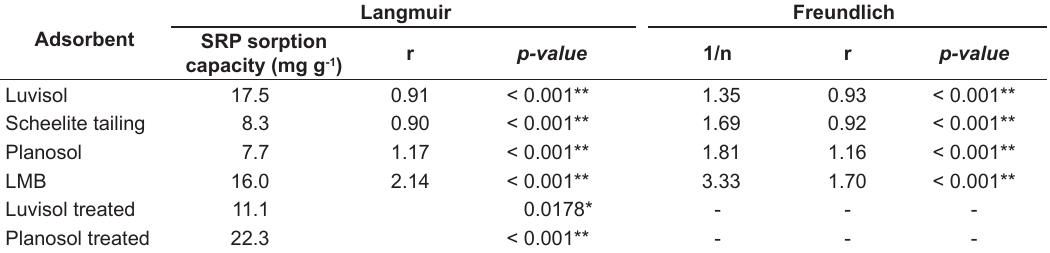
Table 3. Maximum SRP sorption capacity of natural and treated adsorbents using Langmuir and Freundlich